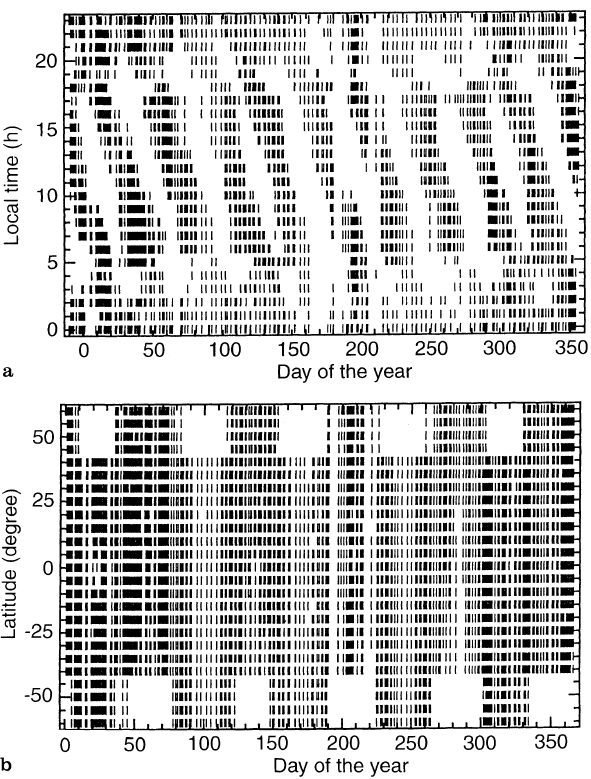
Fig. 1a. local time and b latitude data distribution as a function of days in the